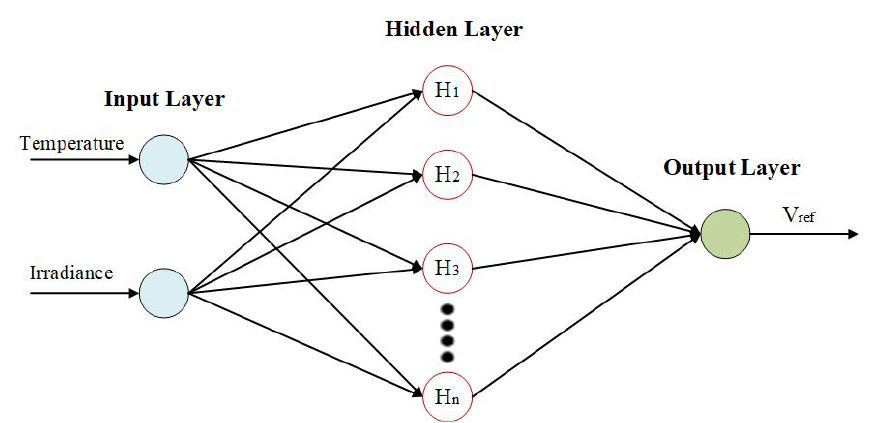
Figure 6. Structure of FFNN for V ref